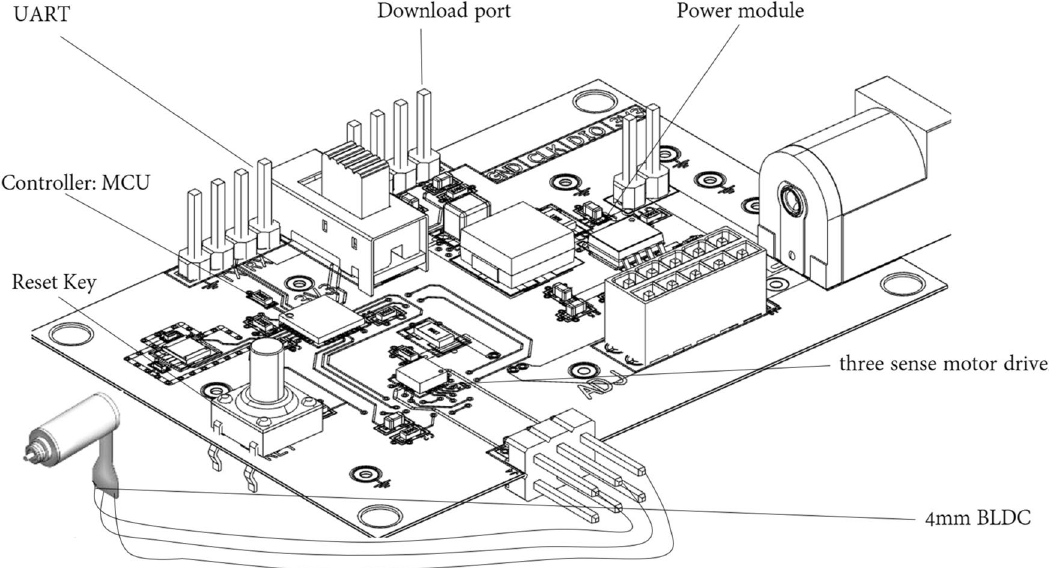
Figure 7. Printed circuit board designed for